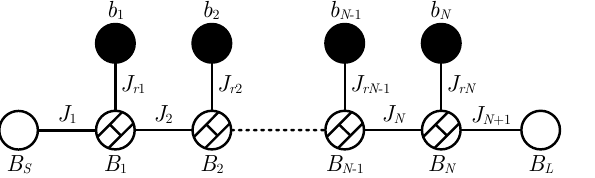
Figure 1. Lowpass nodal scheme of an inline prototype filter with N transmission